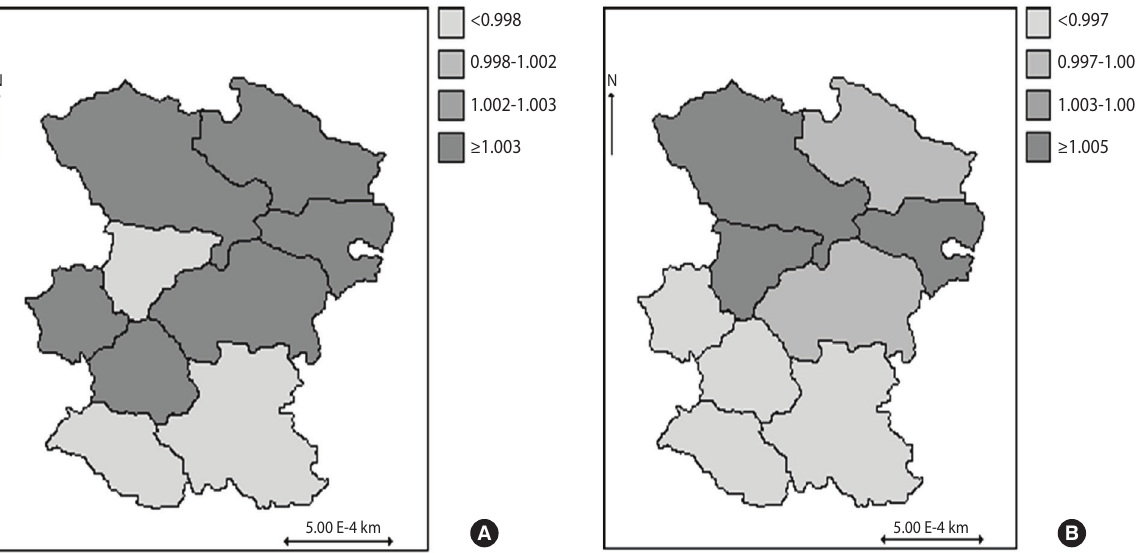
Figure 1. Maps of the HIV/AIDS death risk in a cohort study in Hamadan, Iran (1997-2011) by a spatial Weibull regression model without covariates (A) and with covariates